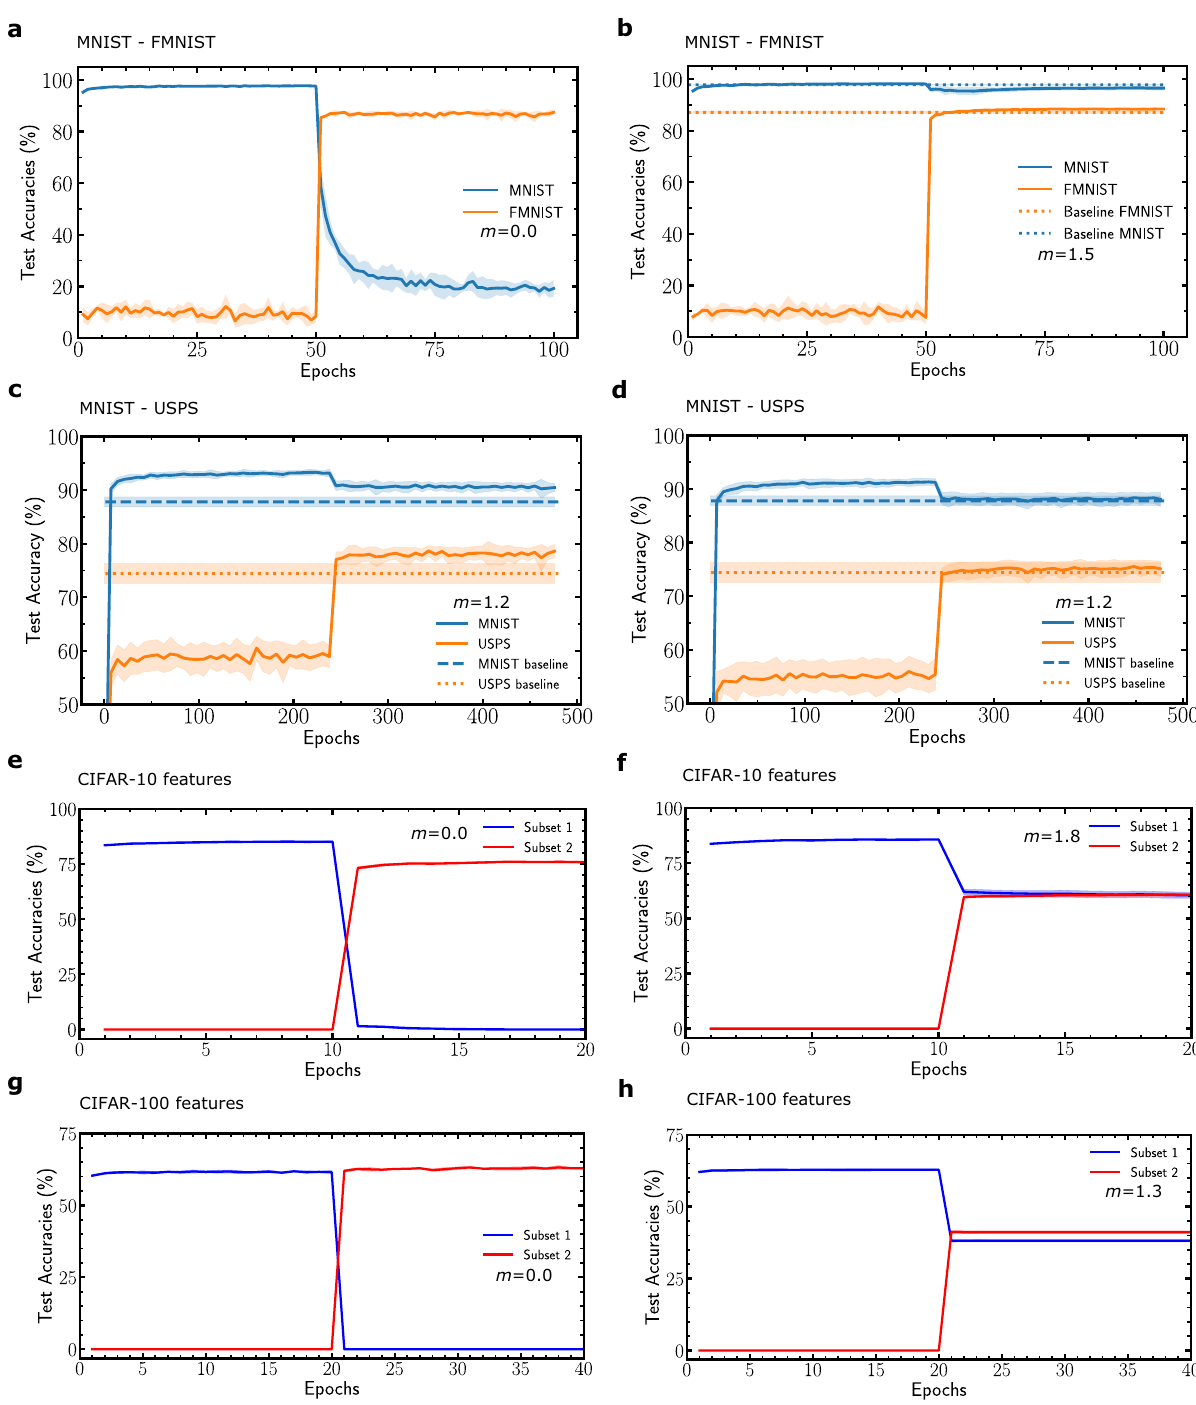
Fig. 4 Sequential learning on various datasets. Binarized neural network learning MNIST and Fashion-MNIST sequentially a without metaplasticity and b with metaplasticity. c Sequential training of the MNIST and USPS datasets of handwritten digits. The baselines correspond to the accuracy reached by non-metaplastic networks with half the number of neurons trained independently on each task. d Presents the same experiment as c , with a metasplastic network featuring a doubled number of parameters with regards to the baselines. e , f Test accuracy when learning sequentially two subsets of CIFAR-10 classes from features extracted by a pretrained ResNet on ImageNet (see Supplementary Note 11). g , h Same experiment with CIFAR-100 features. All curves except c and d are averaged over fi ve runs. c and d are averaged over fi fty runs due to the small amount of data (see Supplementary Note 10). Shadows correspond to one standard